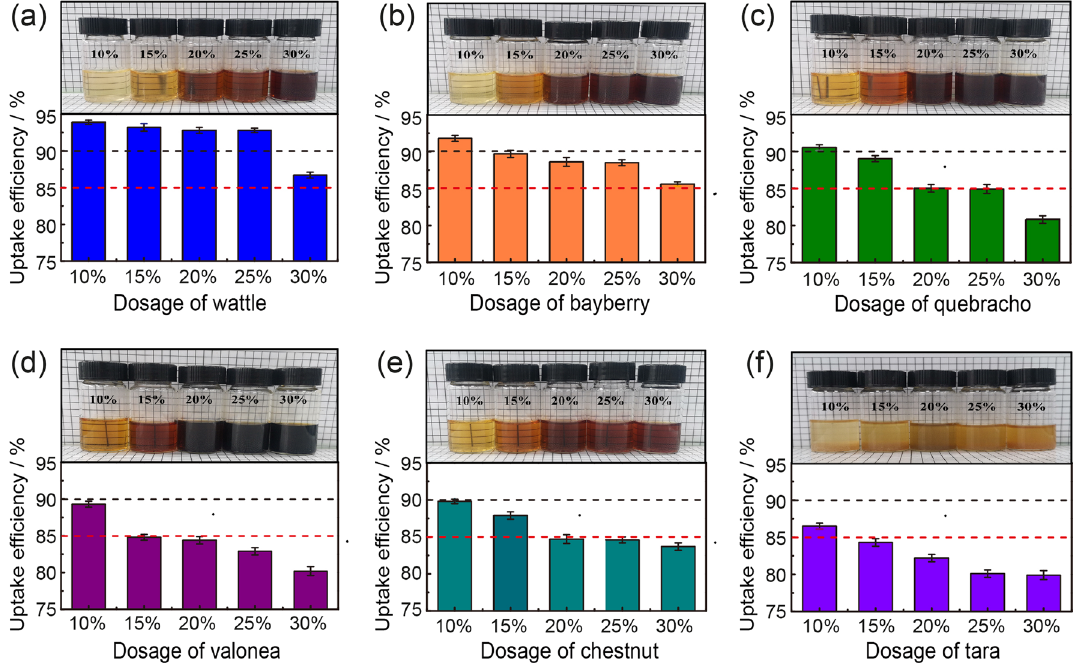
Fig. 2 The photos of tanning spent liquor and uptake efficiency of tannins in different SACC-tannin combination tanning: a wattle, b bayberry, c quebracho, d valonea, e chestnut, and f tara. The concentration of SACC was fixed at 10% and the concentration of tannins varied from 10 to 30